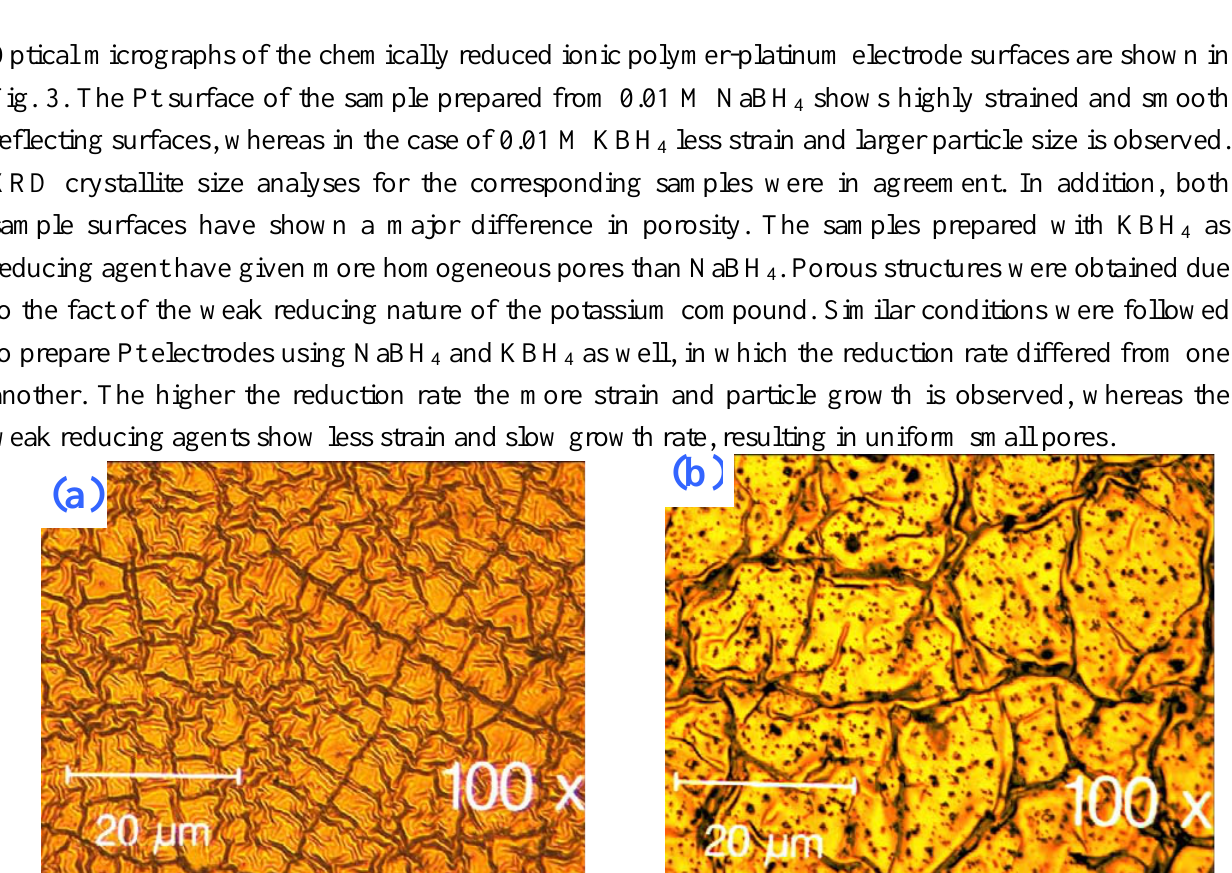
and (b) 0.01 M KBH 4